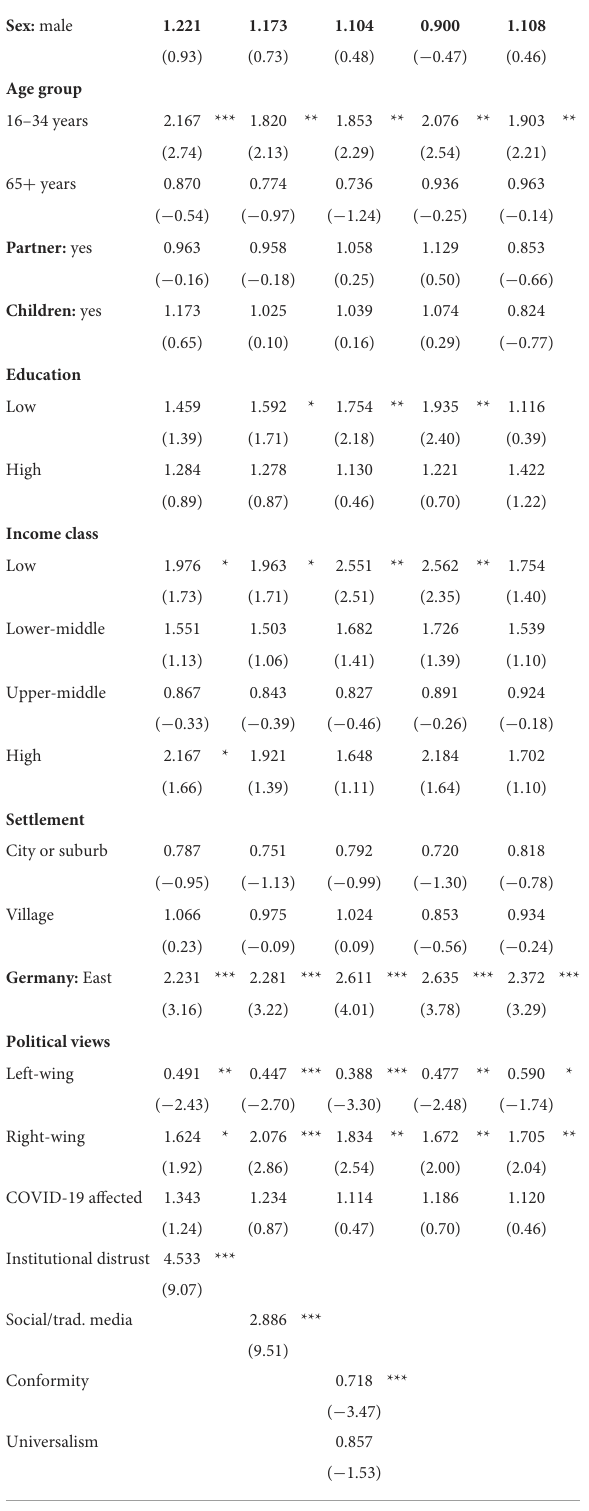
TABLE 4 Binary logistic regression of Corona denial on socio-political and attitudinal characteristics.